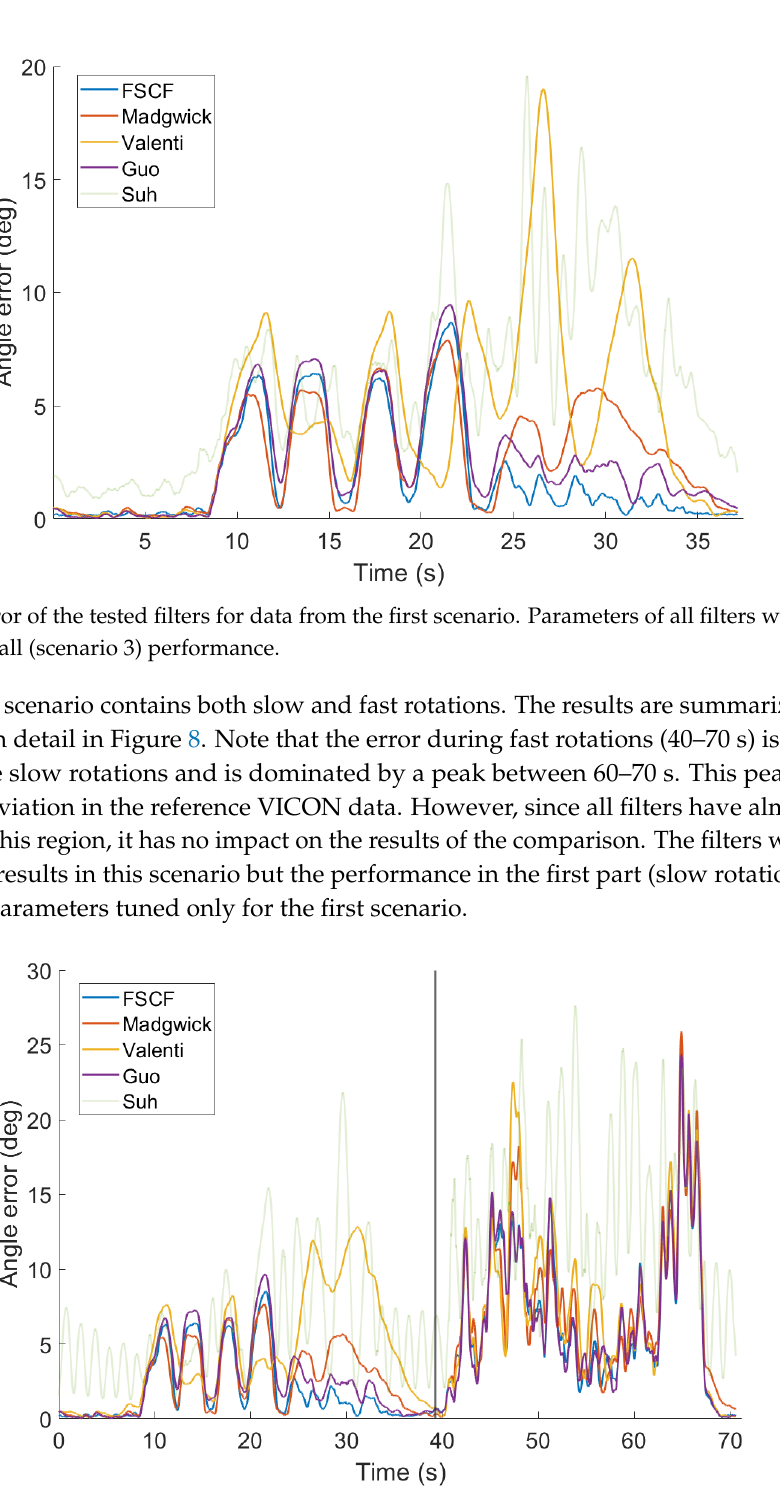
Figure 8. Error of tested filters for data from the second scenario. Parameters of all filters were tuned for best overall (scenario 3)